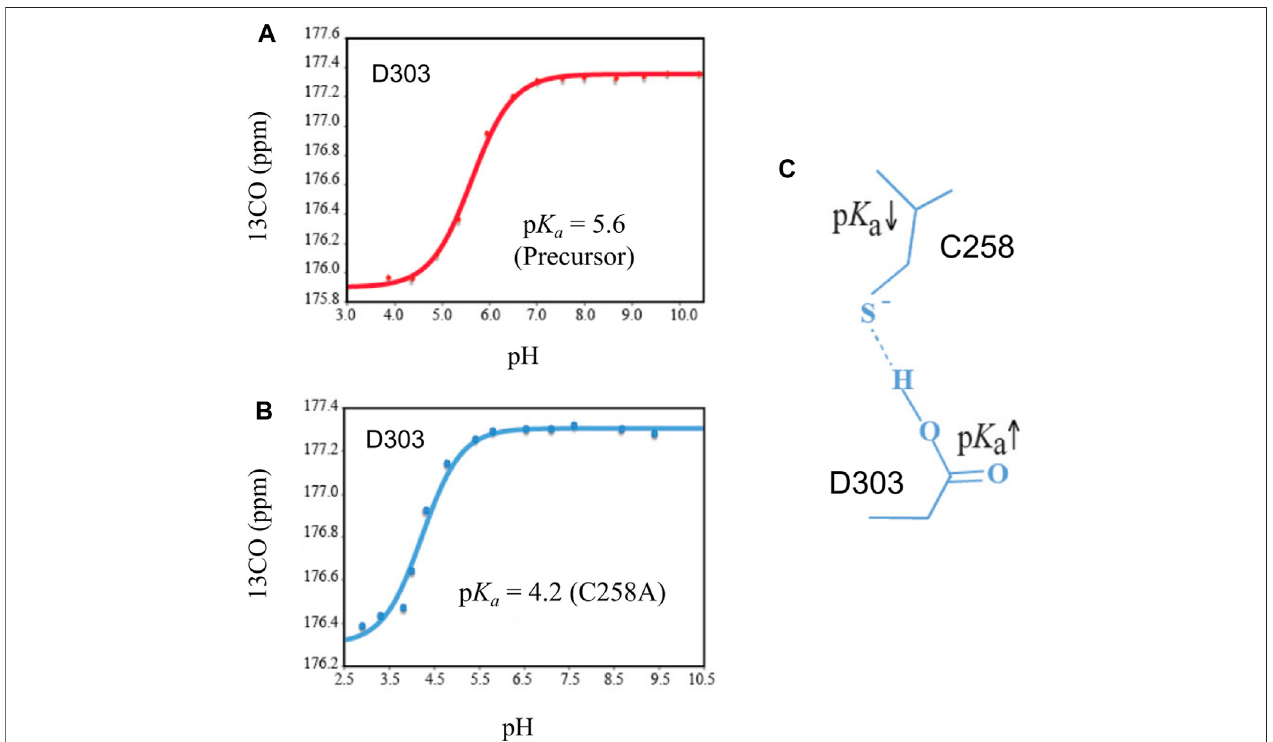
FIGURE4| CouplingofpKabetweenD303andC258. (A) Thep Ka ofD303isincreasedto5.6,asdeterminedby 13 COchemicalshifttitrationwithHB(CB)CO. (B) C1A mutation brings the p Ka of D303 back to normal. (C) The structural basis of p Ka shift and coupling between C258 and D303. Figure from the reference, Xie et al. (2016) with permission.